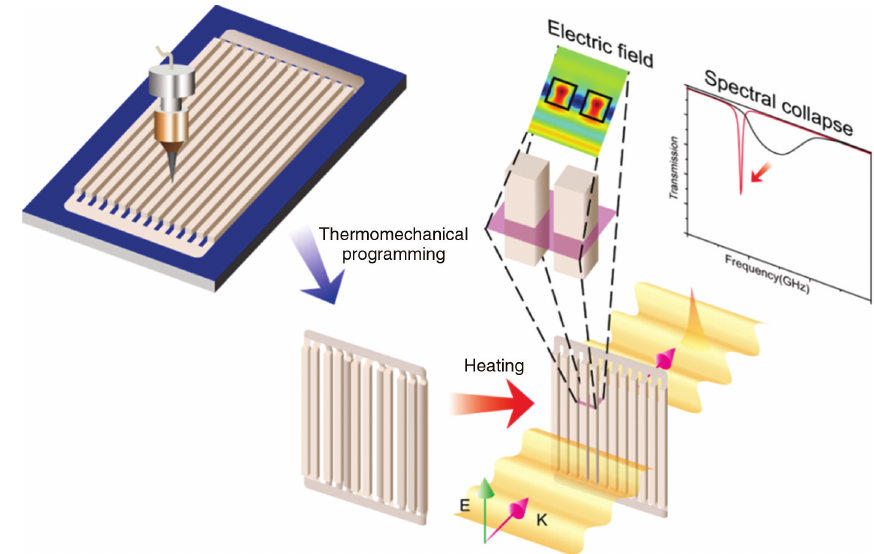
Figure 11: Schematic of a stimuli-responsive SMP photonic